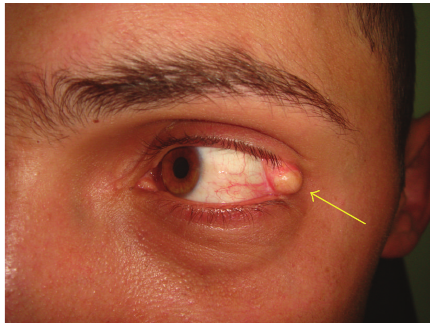
Figure 1: Subconjunctival lesion of the left eye (arrow).